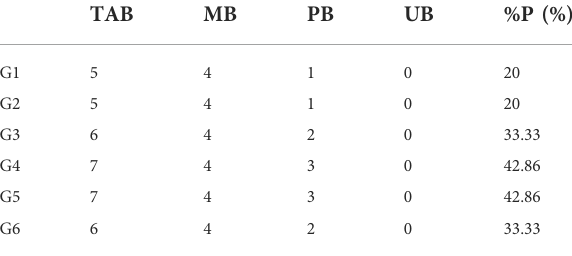
TABLE 5 Number and types of ampli fi ed protein bands and polymorphism percentages.